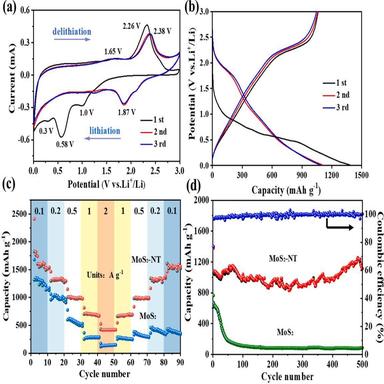
CV curves at 0.1 mV s−1 (a) and the charge/discharge curves (b) at 0.5 A g−1 for MoS2-NT, the rate performances at different current density of MoS2-NT and MoS2 (c), the cycling test at 0.5 A g−1 for MoS2-NT and MoS2 (d).